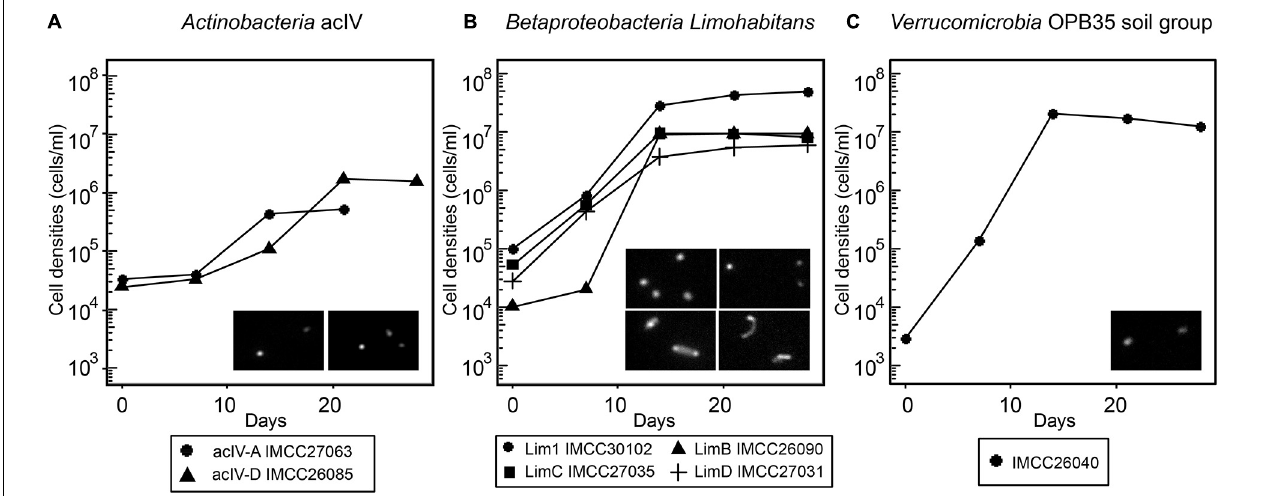
FIGURE 4 | Growth curves of selected HTC isolates revived from frozen glycerol stocks. (A) acIV-A and acIV-D. (B) Lim1, LimB, LimC, and LimD. (C) OPB35 soil group. The HTC isolates are prefixed with the “IMCC” abbreviation (Inha Microbe Culture Collection). The inset images are DAPI-stained micrographs taken with an epifluorescence microscope; (A) left, IMCC27063; right, UMCC26085. (B) upper left, IMCC30102; upper right, IMCC26090; below left, IMCC27035; below right,